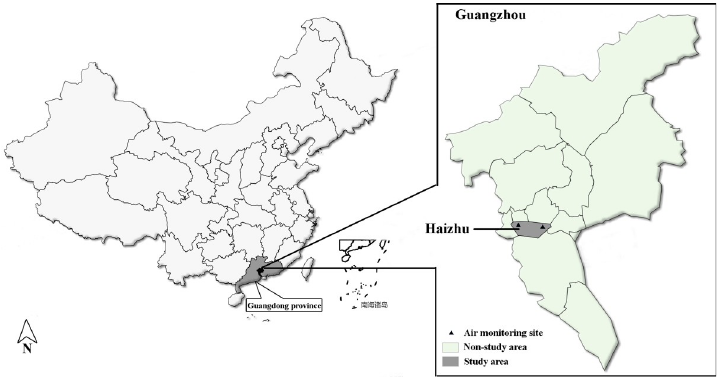
Fig 1. District map of Haizhu District, Guangzhou, China, with two air monitoring station locations.